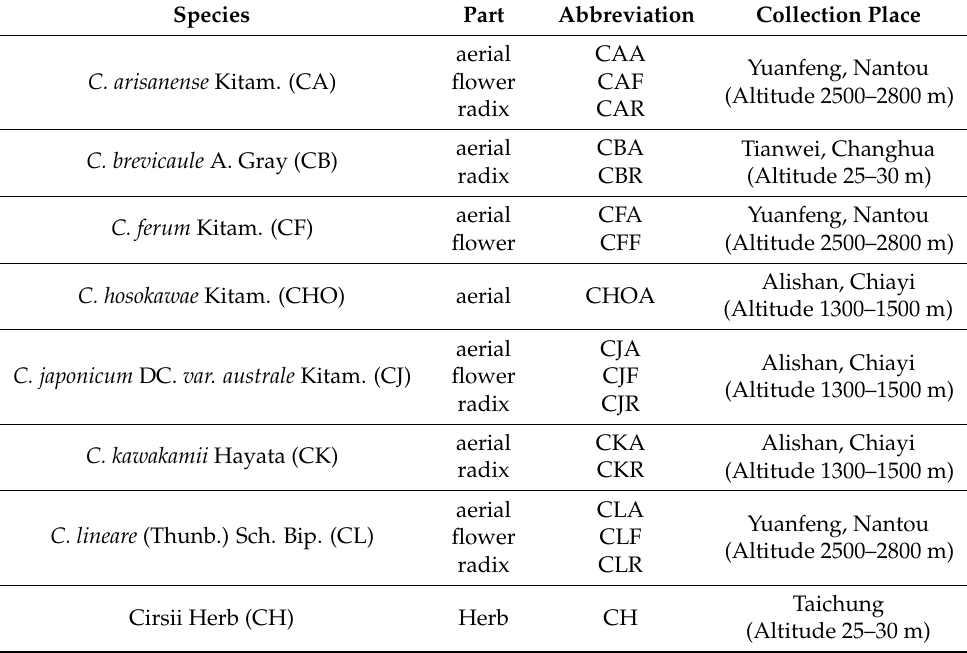
Table 6. Abbreviations and Collection Places of Taiwanese Cirsium species and Cirsii